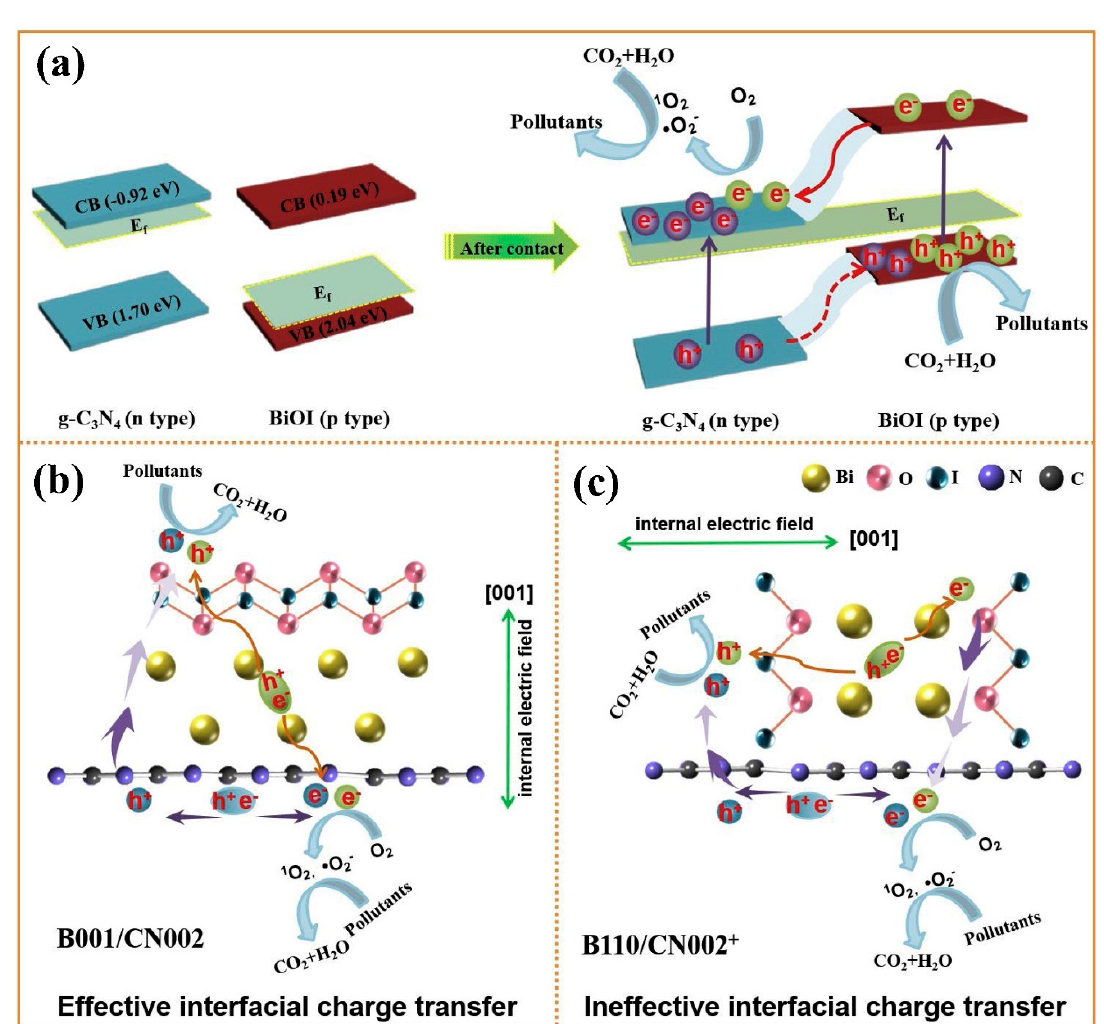
Figure 13. ( a ) Schematic depicting the formation of p-n junction and the proposed charge separation process in a heterojunction formed by coupling the top-top facets of BiOI and g-C 3 N 4 , i.e., (001)-BiOI/(002)-g-C 3 N 4 under visible light irradiation. Schematic depicting the proposed photodegradation mechanism over ( b ) (001)-BiOI/(002)-g-C 3 N 4 and ( c ) (110)-BiOI/(002) + -g-C 3 N 4 (positively charged g-C 3 N 4 ). Reprinted from Ref. [112] with permission from Elsevier.